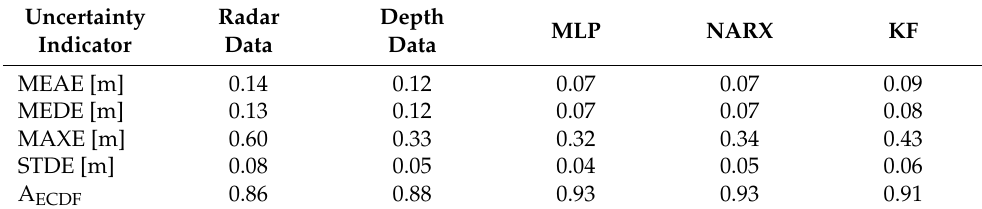
Figure 8. Zoom on the empirical cumulative distribution functions characterising the position errors, obtained in EXP#2. Table 2. Values of the uncertainty indicators, calculated on the basis of the position errors, obtained in EXP#2.